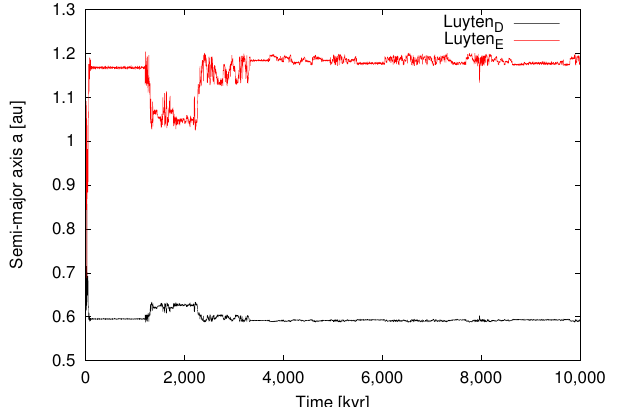
Figure 1. Case 0 ( e D = 0.0085, e E = nominal). Time evolution of the two outer planets over 10 Myr. This is unstable configuration.